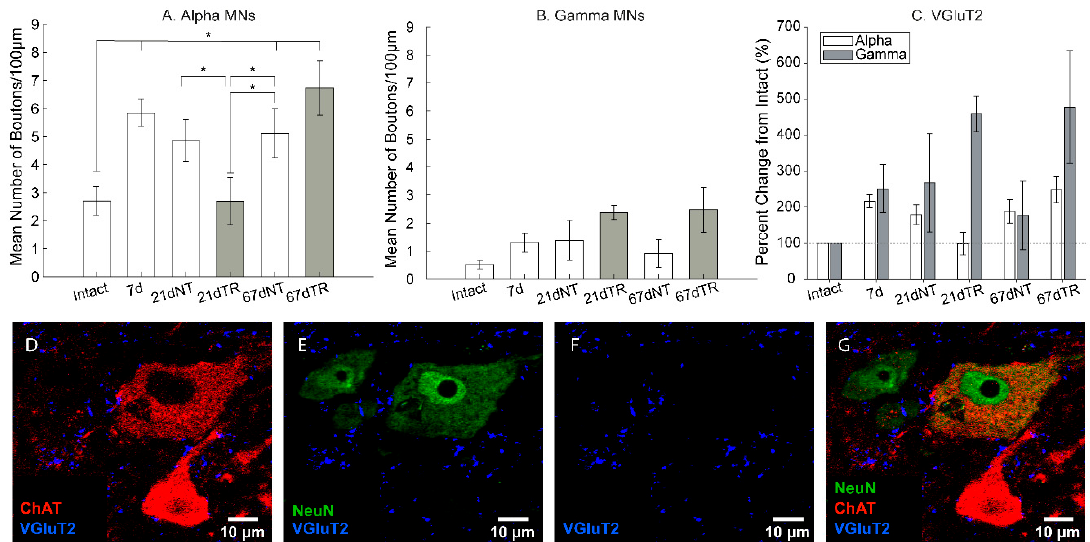
Figure 3. Glutamatergic boutons were detected with the antibody against VGluT2. ( A ) In α -MNs, significant differences in the absolute number of boutons were observed between 67 dpi groups and intact, 7d, and 21dNT groups. ( B ) In γ -MNs, no significant differences in the absolute number of VGluT2 boutons were observed. In ( C ), the percent change of VGluT2 boutons was significantly higher in γ -MNs. ( D ) Motoneurons were identified as ChAT+ (red) cells in the ventral horn. ( E ) NeuN (green) is only expressed in α -motoneurons and other interneurons. ( F ). VGluT2 boutons (blue) were identified in close apposition to both γ - and α -motoneurons. ( G ) Combined triple filters. * = p < 0.05.